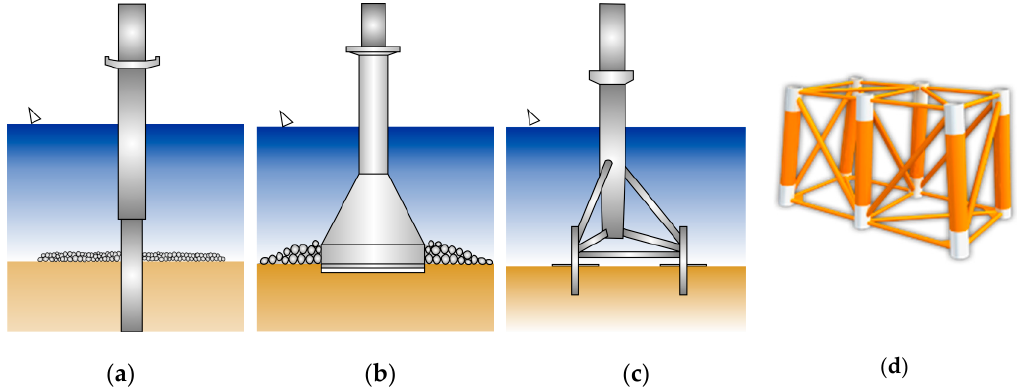
Figure 1. Various foundation types for offshore wind turbines: ( a ) mono-pile, ( b ) gravity base, ( c ) tripod, and ( d ) jacket type.